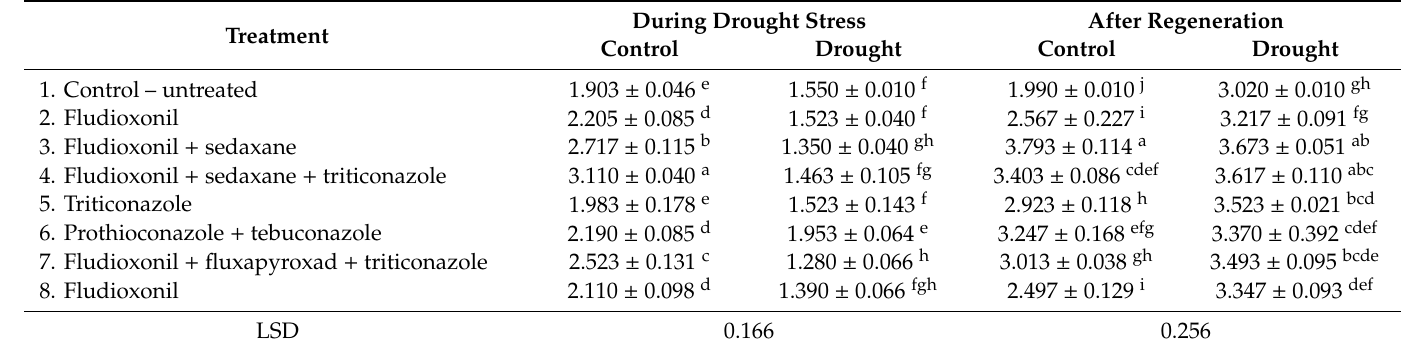
Table 4. The influence of the seed treatment and drought stress on transpiration rate – E (mmol × m − 2 × s − 1 ) during drought stress and after